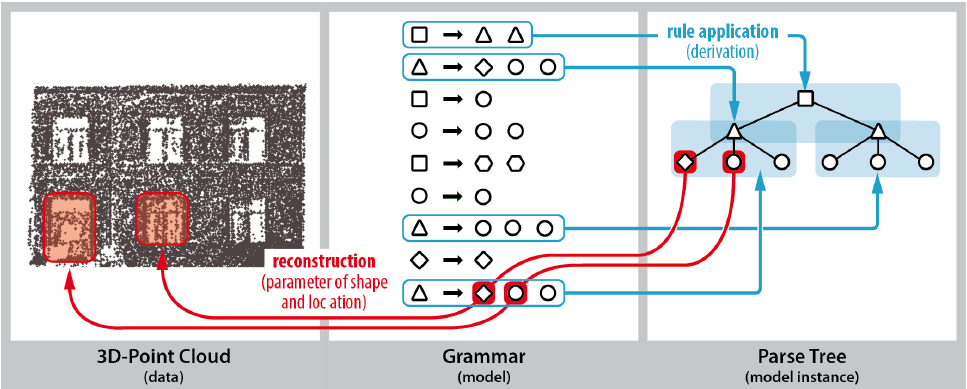
Figure 1: Offline parsing of 3D point clouds using formal grammars.